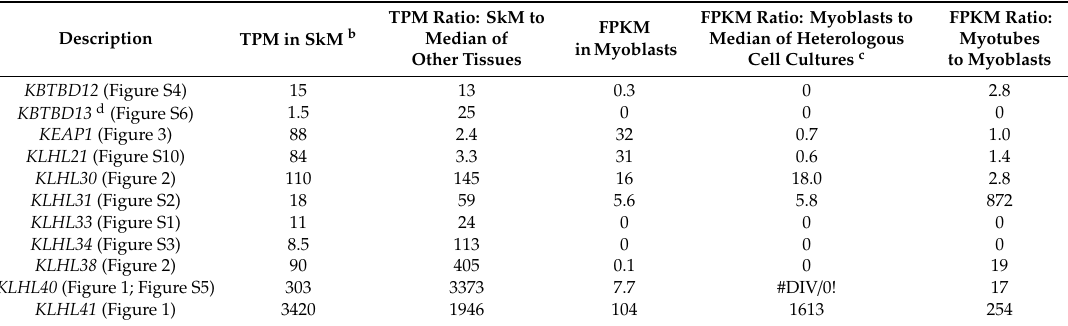
Table 1. KLHL family genes that are preferentially expressed in skeletal muscle a .